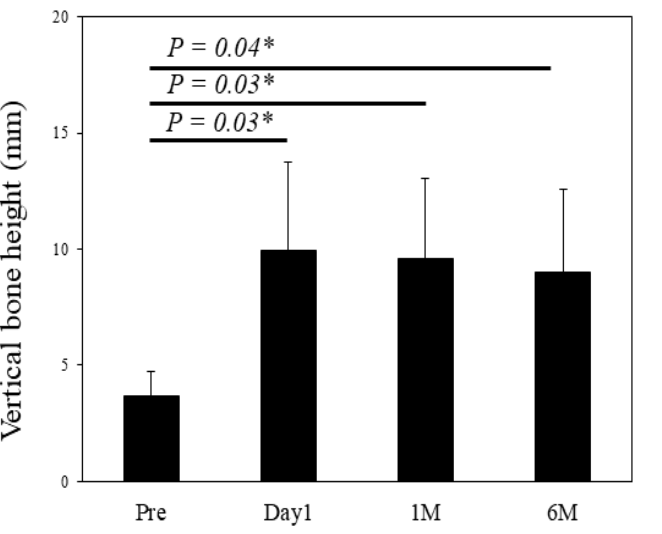
Figure 4. Quantitative measurement of vertical bone height at the transplanted site is shown. *; p < 0.05, statistically significant difference.